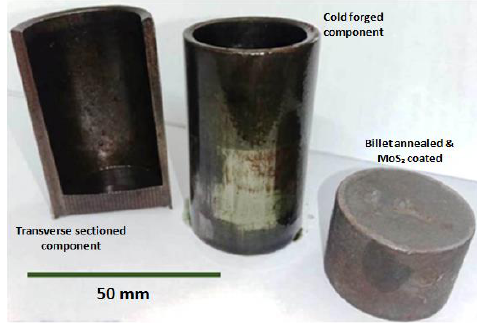
Figure 7. Billet as machined, annealed, MoS₂ coated forged, and sectioned part.